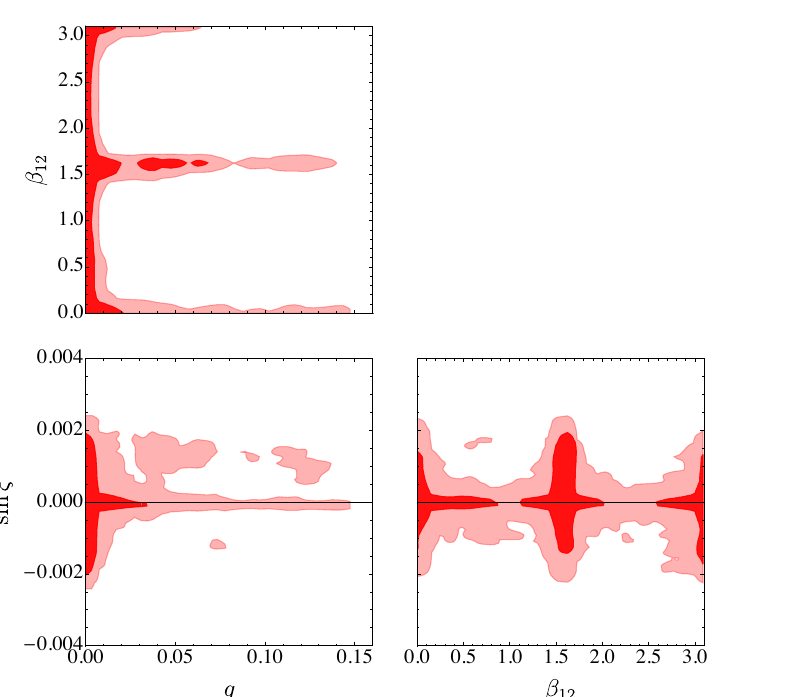
Figure 10. 68% and 95% C.L. regions for the L µ − L τ coupling g , the rotation angle β 12 and the mixing angle sin ξ .